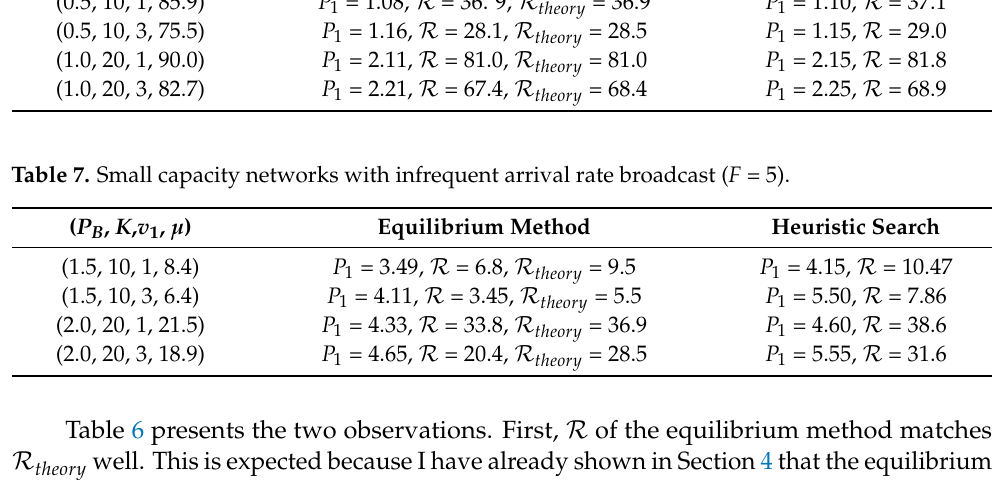
Table 6. Large capacity networks with frequent arrival rate broadcast ( F = 100). ( P B , K , v 1 , µ )